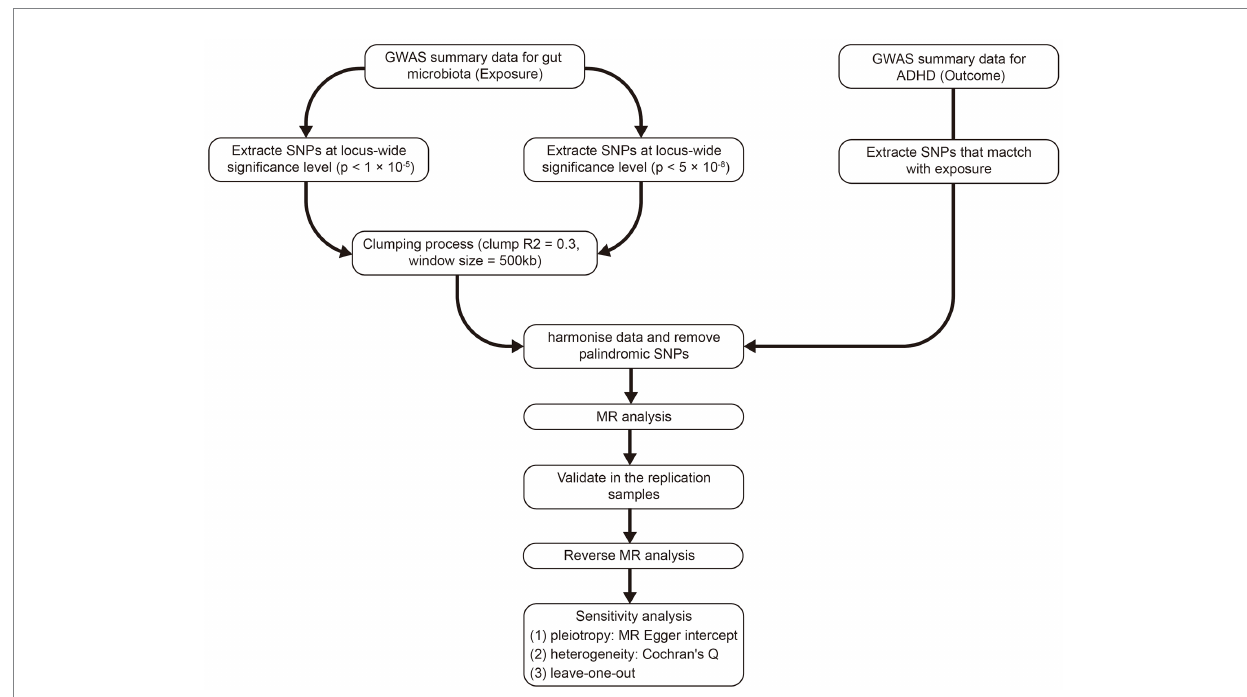
FIGURE 1 The whole workflow of MR analysis. MR, Mendelian randomization; ADHD, attention deficit hyperactivity